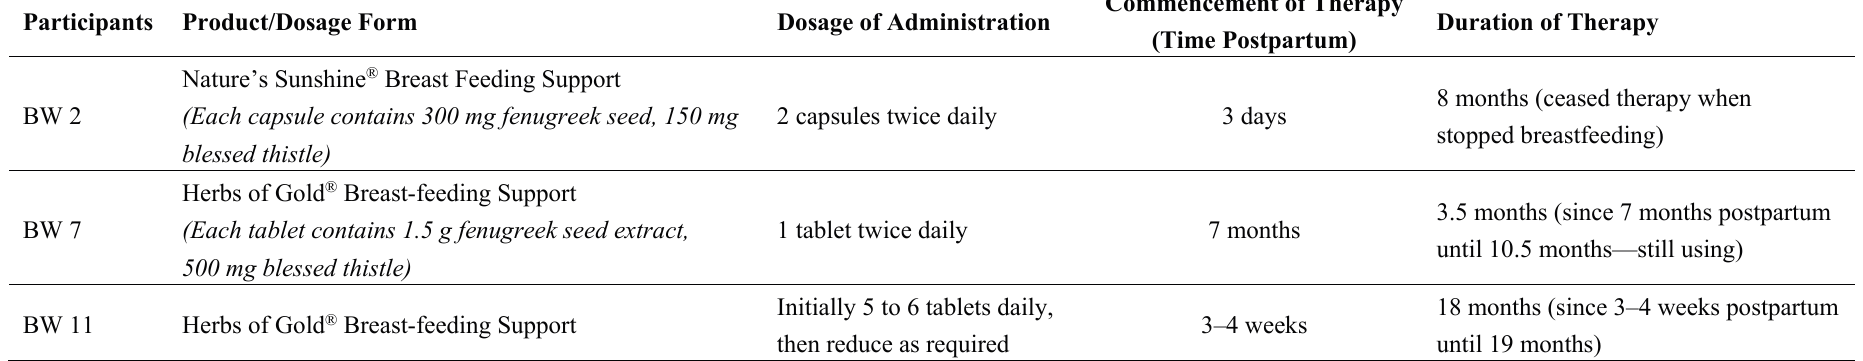
Table 2. Summary of the pattern of use: fenugreek and blessed thistle combination products.